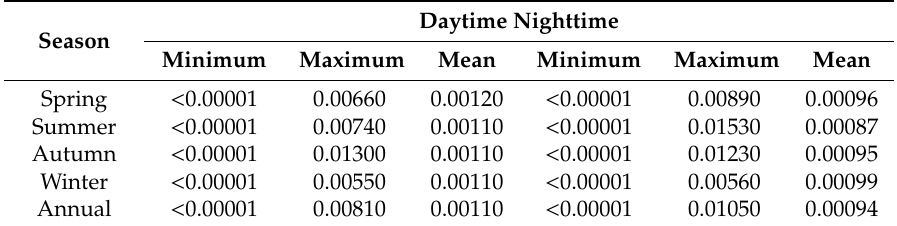
Figure 3. The top panel is the histogram bin range of IWC (red box) and extinction coefficient. The bottom panels show histograms of IWC derived from the 10-year measurements of the CALIOP for four seasons. Table 2. Same as in Table 1, but for IWC. The unit of IWC is g/m 3 .